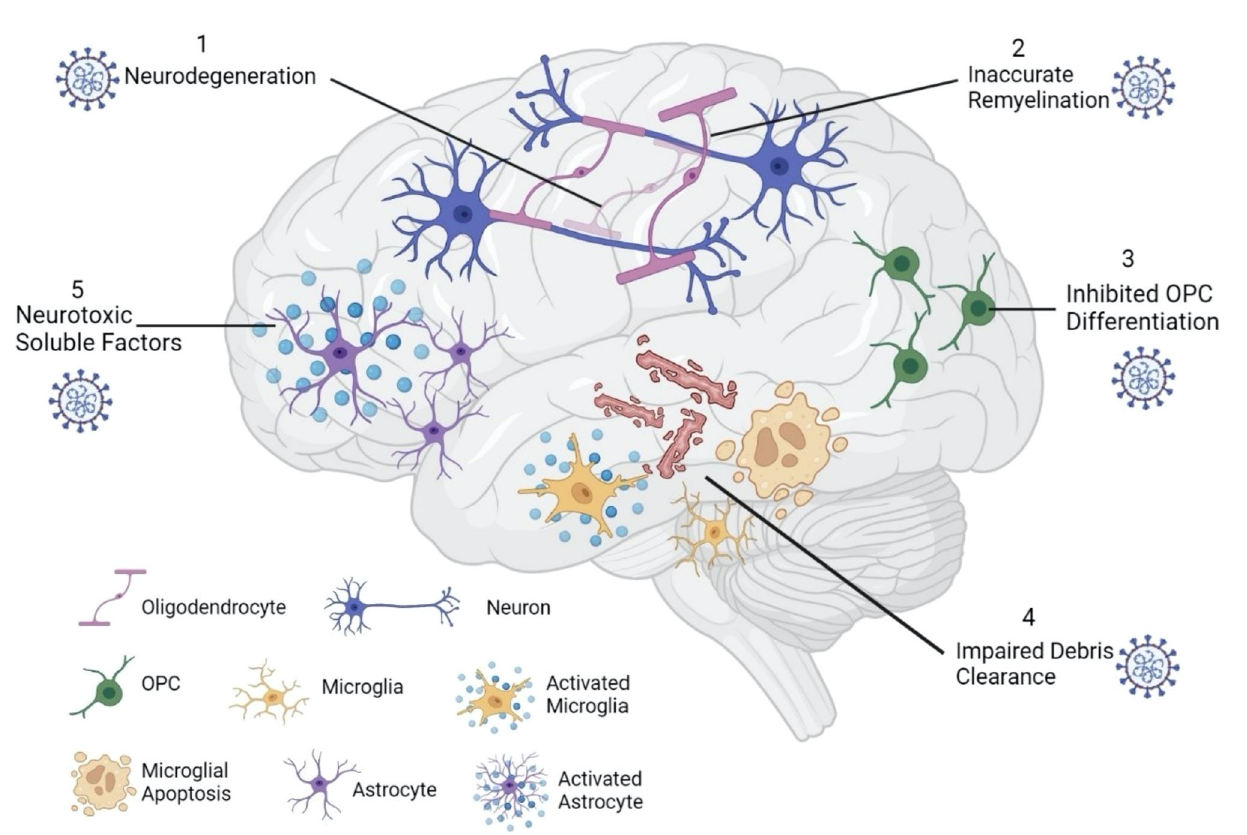
FIGURE 2 | SARS-CoV-2 impacts the glial landscape. Once inside the brain parenchyma, SARS-CoV-2 can alter the neural microenvironment by impacting glial cell function. Infected oligodendrocytes can result in neurodegeneration (1), leading to inaccurate remyelination by surviving oligodendrocytes (2). Inhibited OPC differentiation (3) further impairs the remyelination process, as new oligodendrocytes are not formed. While activated microglia secrete proin fl ammatory cytokines that are damaging to neural tissue, microglial apoptosis reduces myelin debris clearance (4), further suppressing remyelination potential. Lastly, activated astrocytes may secrete neurotoxic soluble factors (5) that can impair neuronal viability and damage